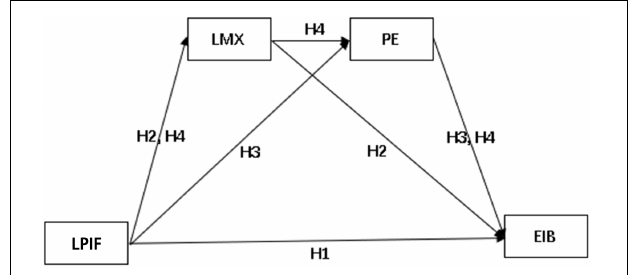
FIGURE 1 | Theoretical model. Note: LPIF, leaders’ positive implicit followership; LMX, leader–member ex-change; PE, psychological empowerment; and EIB, employees’ innovation